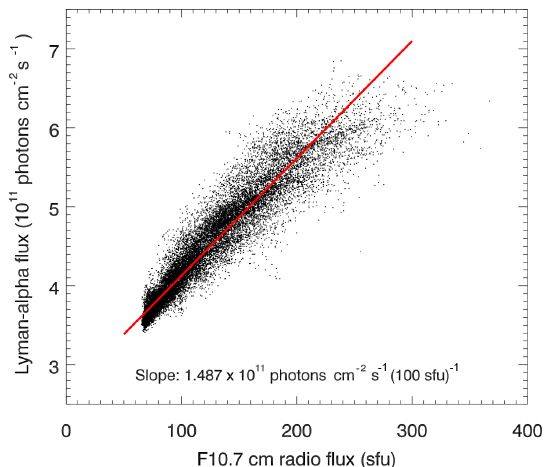
Figure 8. Scatter plot of daily values of the Lyman- α flux and F10.7cm radio flux for the period from February 1959 to Febru- ary 2017. The red line corresponds to a linear regression of the data points.